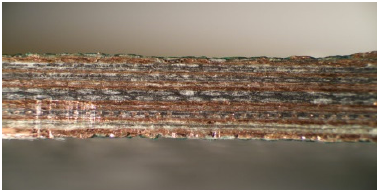
Figure 1. Macroscope cross section image of PWB .